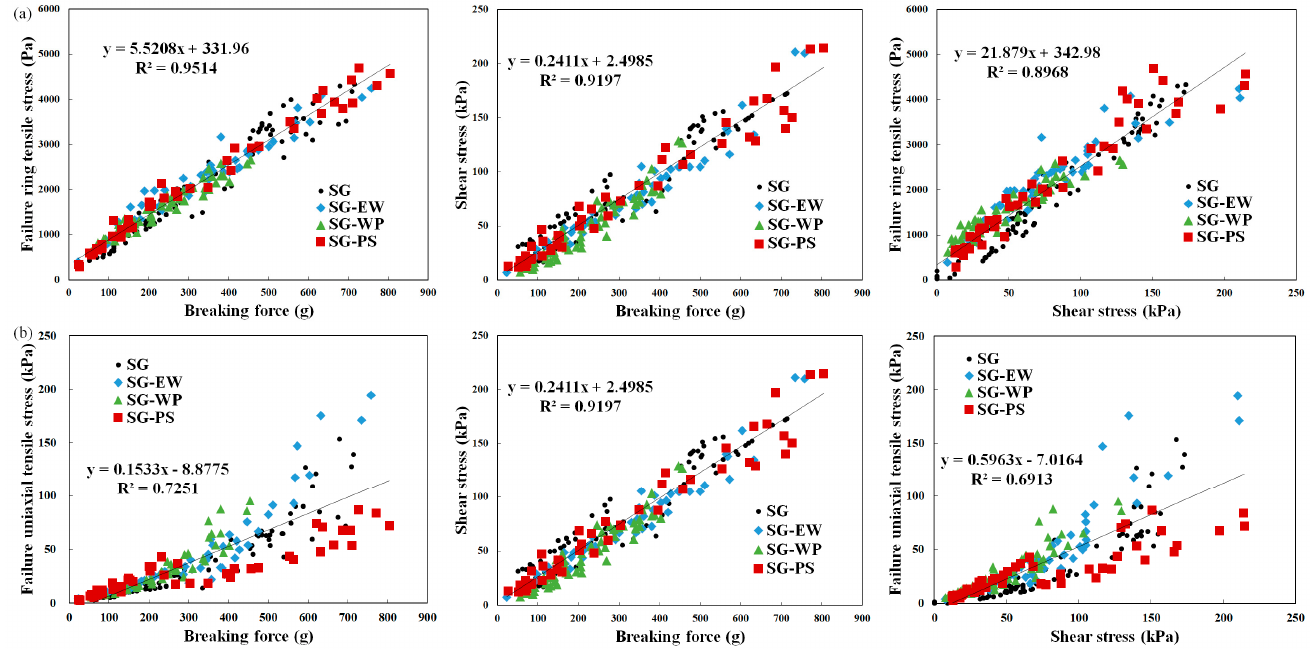
Figure 2. The correlation of textural properties related to the hardness of surimi gels. ( a ) Failure hoop stress and ( b ) failure uniaxial tensile stress. The trend line for each figure was based on surimi gel without any added ingredients.